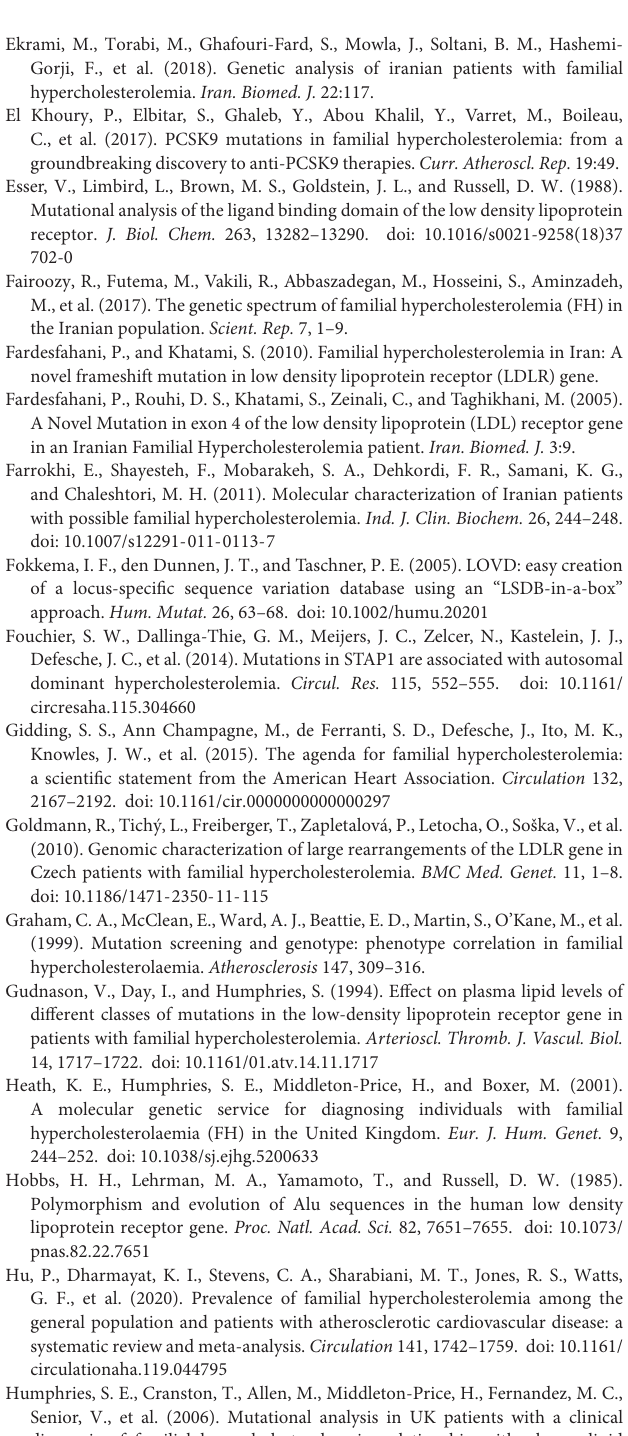
Supplementary Table 3 | All nucleotide variations of PCSK9 gene found in this study. Supplementary Table 4 | The previously reported pathogenic mutations in Iranian